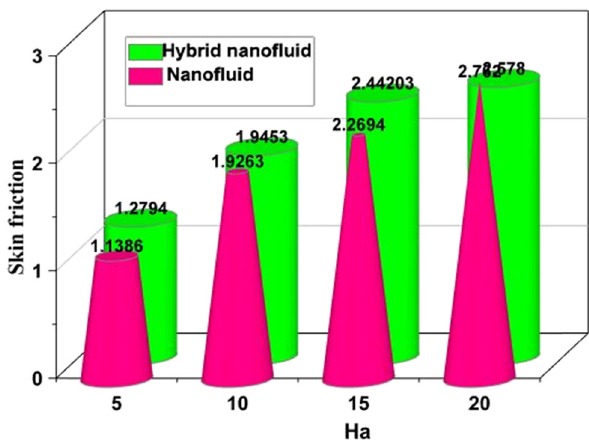
Figure 6: Skin friction versus